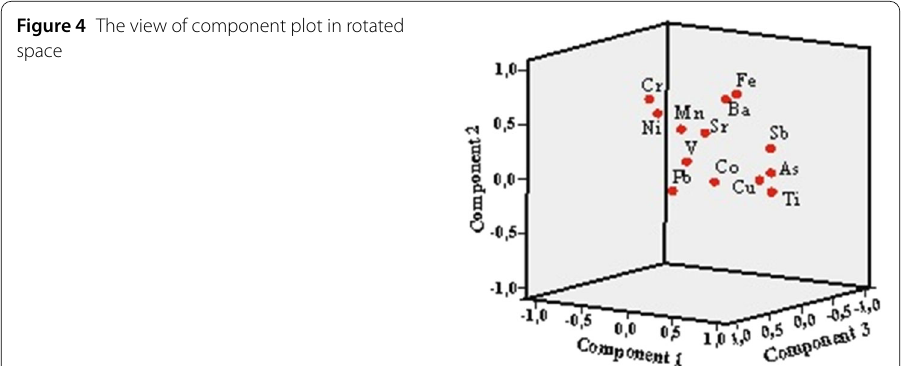
Figure 4 The view of component plot in rotated